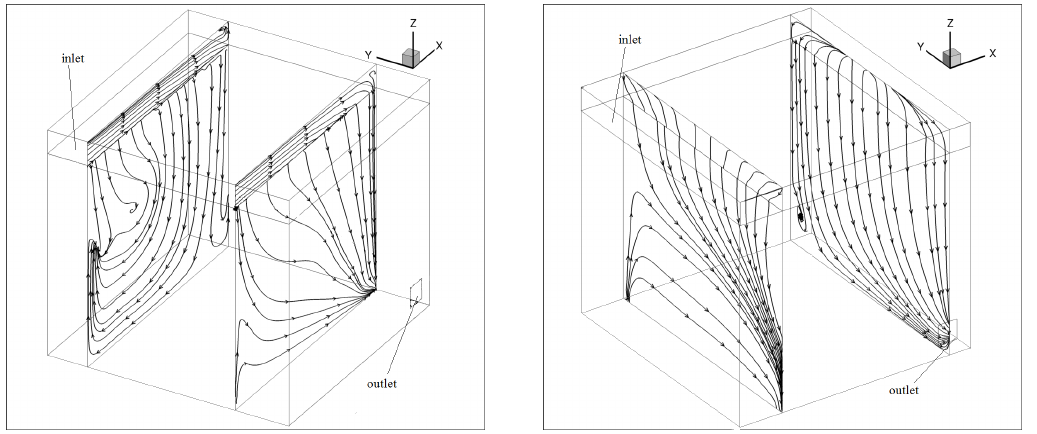
Figure 11. Streamlines for the continuous distribution and Outlet 1 configuration.